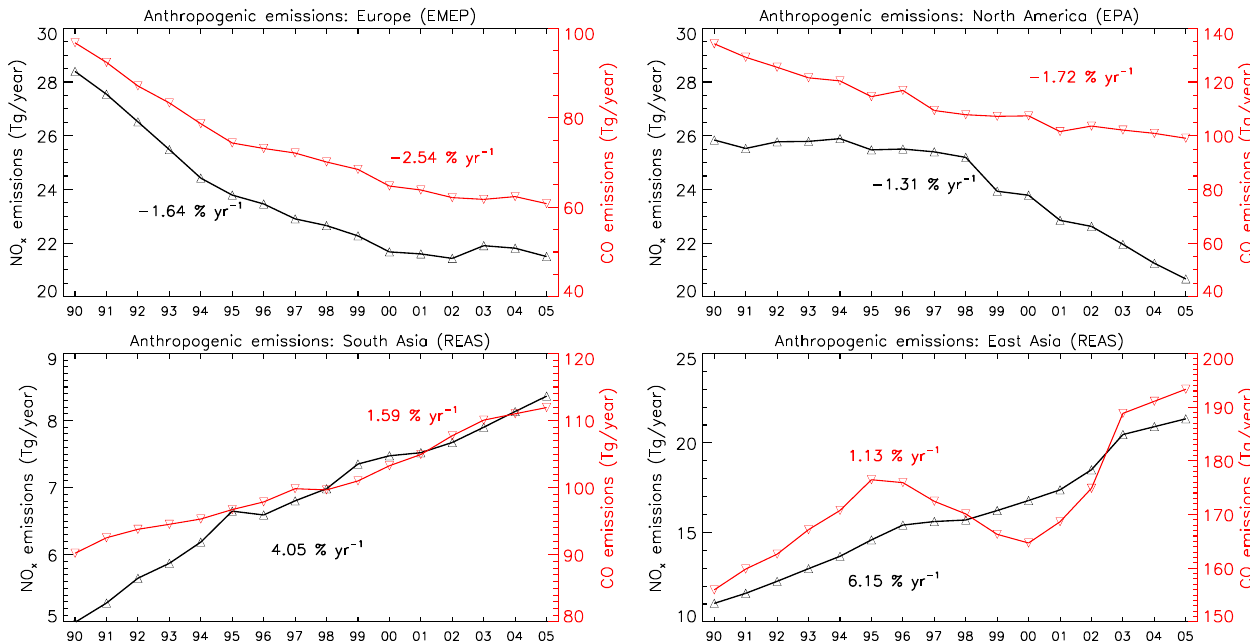
Fig. 1. Interannual (from 1990 to 2005) anthropogenic emissions of NO x (in black) and CO (in red) implemented in the GEOS-Chem model over four important anthropogenic source regions: Europe, North America, South Asia, and East Asia.